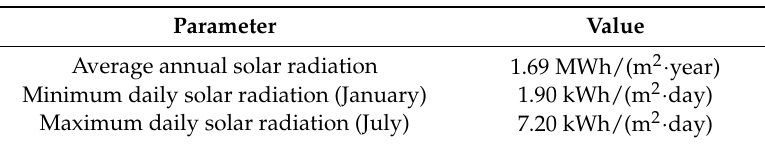
Table 1. Solar radiation data in Pantelleria.